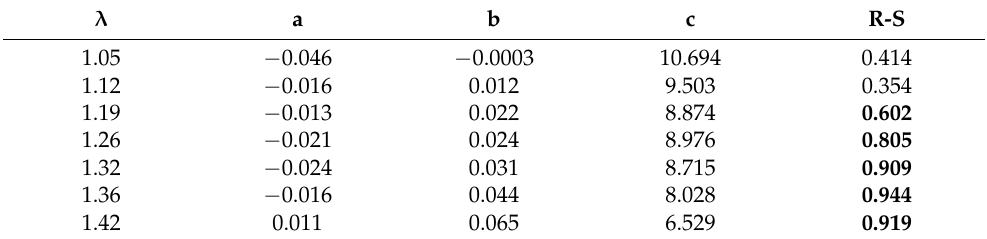
Table 4. Fitting of IMEP and PMAX distribution under different λ